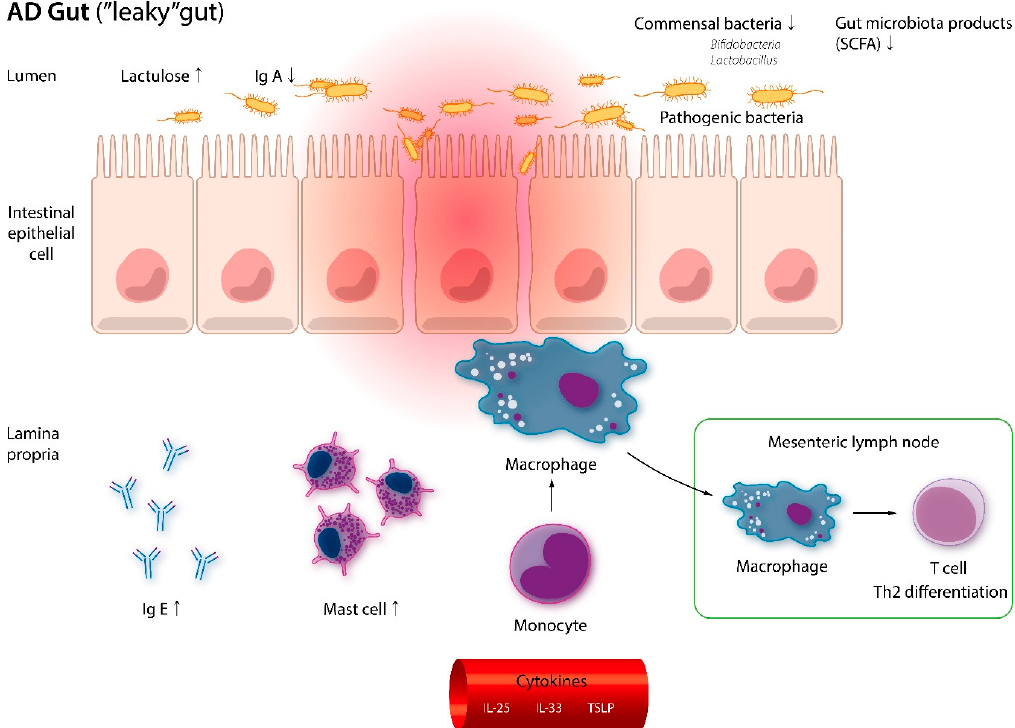
Figure 3. Muscosal barrier disruption in AD. Patients with AD have dysbiosis and less short-chain fatty acids (SCFAs) in the gut. In response to pro-inflammatory cytokines, monocytes migrate and differentiate into macrophages. Greater access to luminal antigen also causes T cells to transform into Th2 cells in the draining lymph nodes. Immunoglobuin E (Ig E) and mast cells are also more abundant in the lamina propria. IgE: Immunoglobulin E; IL: Interleukin; Th2: T helper 2 cells; TSLP: Thymic stromal lymphopoietin; IgA: Immunoglobulin A.